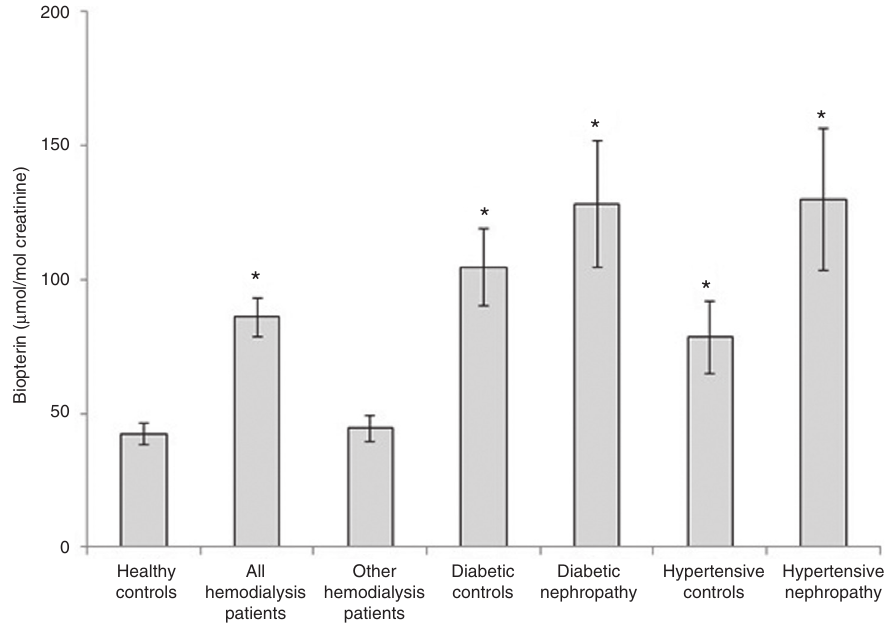
Figure 1 Comparison of urinary biopterin levels ( μ mol/mol creatinine) in the study groups. Values of the urinary biopterin levels are shown as mean ± standard error of the mean. *p < 0.05, vs. healthy